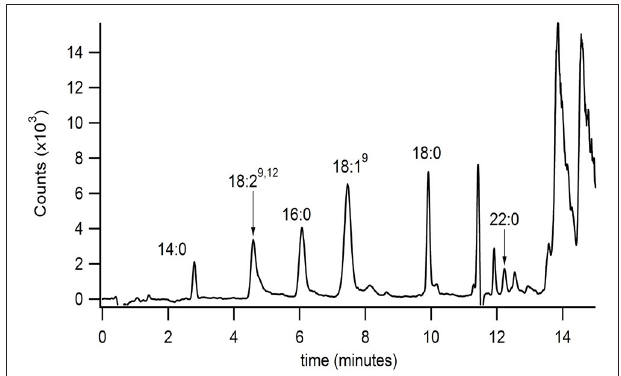
FIGURE 4 | Isolation and identification of PFAMs in brain. The equivalent of 10 Swiss-Webster mouse brains (with mid brain removed) were Folch-Pi extracted. Samples were then subjected to MDLC using normal phase chromatography, and the peak corresponding to PFAM class of lipids were then separated by reversed phase chromatographs (as described in the text). PFAM substituents where identified by MS/MS as described Figure 3 .